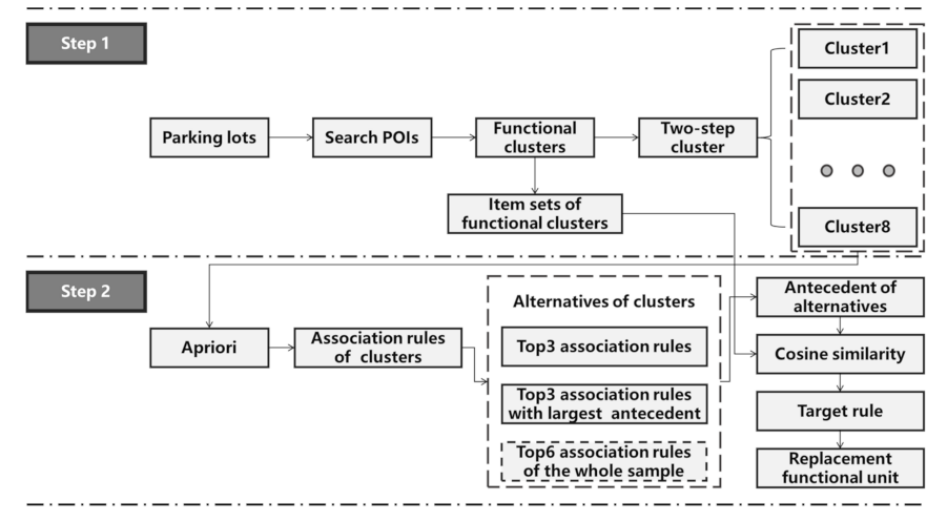
Figure 4. The research process.